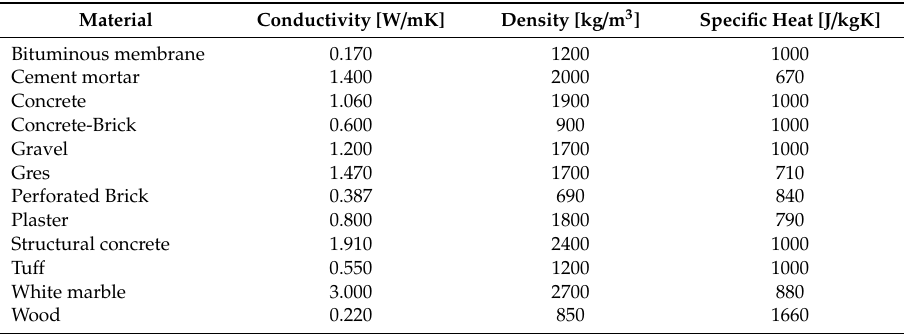
Figure 6. Thermal zones. The highlighted zones refer to the rooms where the monitoring surveys were carried out. Table 3. Material properties for database upload in IDA-ICE for first guess